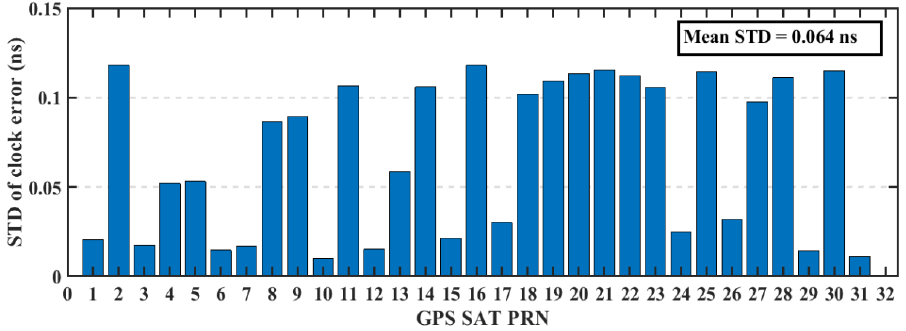
Figure 4. RMS of Galileo satellites ’ orbits based on NAVCAST real-time products.